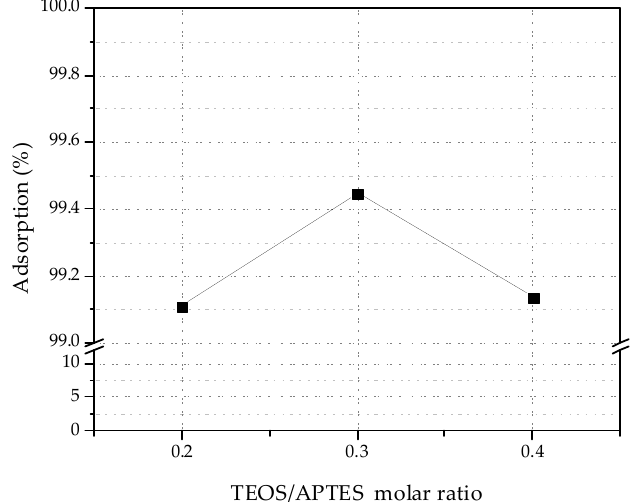
Figure 6. Effect of NH 2 groups concentration for the adsorption of Pb(II) ions onto x NH 2 /DMS ‐ 1 materials. Adsorption conditions: initial volume 20 mL; 0.10 g of adsorbents; contact time 60 min; temperature solution 30 °C